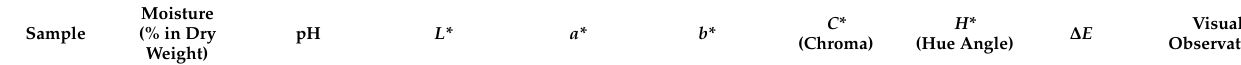
Figure 2. Zeta − potential of spray-dried powders of controlled casein micelles (CMs), CMAQP, CMFDP, and CMWLAG. (Values are from triplicates; the mean and standard deviation are shown. Values significantly different of all spray-dried powders (CMAQP, CMFDP, CMWLAG) from CMs controlled when analyzed by one − way ANOVA with Dunnett’s test analysis indicated with aster- isks: * p < 0.01, ** p < 0.001, **** p < 0.0001.). Table 1. Moisture contents, pH, color, and visual observations of spray-dried powders of anthraquinone-loaded casein micelles. (Values are mean and standard deviations from triplicate data. The data were analyzed using one-way ANOVA and Tukey’s post hoc HSD tests. The different letters in superscript (a, b, c) within rows indicate statistically significant differences ( p < 0.05).